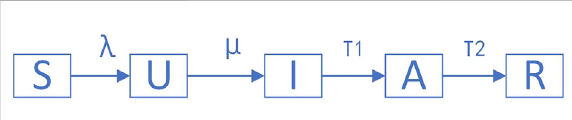
FIGURE 2 Schematic of the disease dynamic. Individuals may be in fi ve states: susceptible(S)to thedisease, infected but undiagnosed(U), Infectious (I) but yet not ascertained, ascertained (A), and recovered or dead